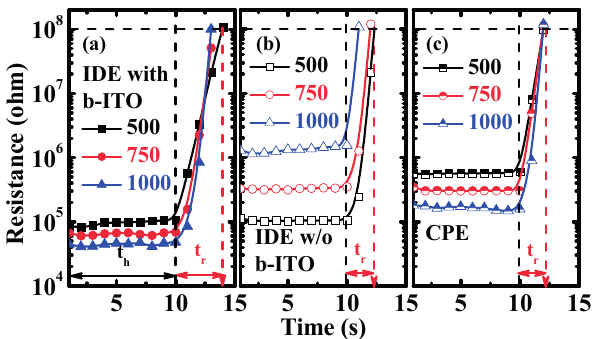
Figure 8. The resistance versus time ( R-t ) characteristics after the release of pressure of the pressure sensors with ( a ) inter-digitated electrode (IDE) with bottom indium-tin-oxide (b-ITO); ( b ) IDE without b-ITO; and ( c ) cross-point electrode (CPE) structures under a pressure of 20 kPa with a hold time of 10 s.